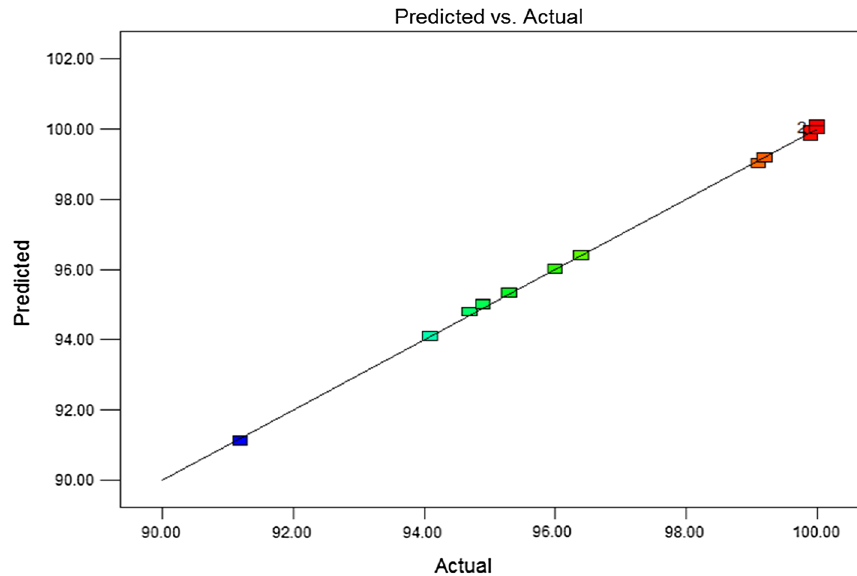
Fig. 3 The experimental model (squares) and predicted results (dash) for Escherichia coli